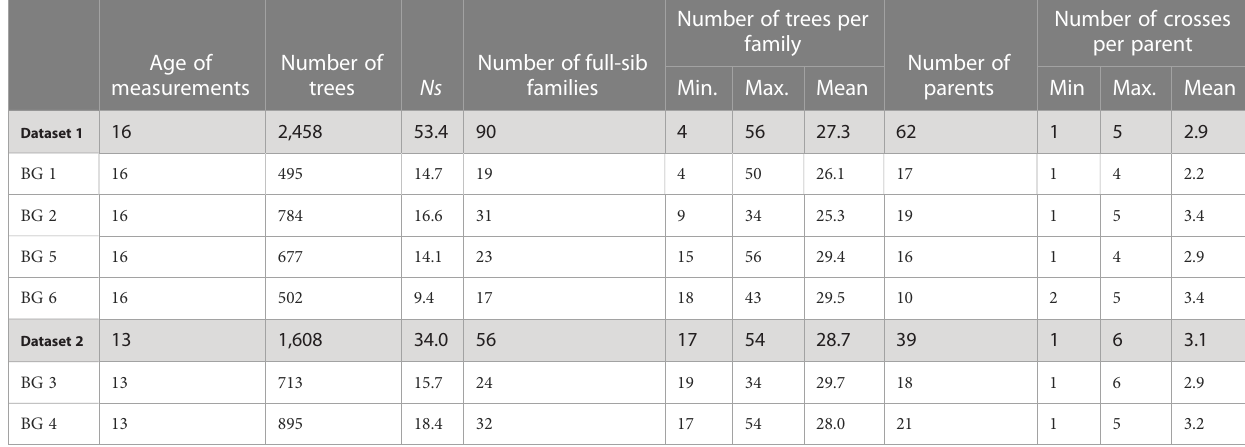
TABLE 1 Number of white spruce trees, full-sib families, and parents sampled for each breeding group (BG) and summarized for all the 4,066 individuals retained for analyses, after pedigree correction using marker information.